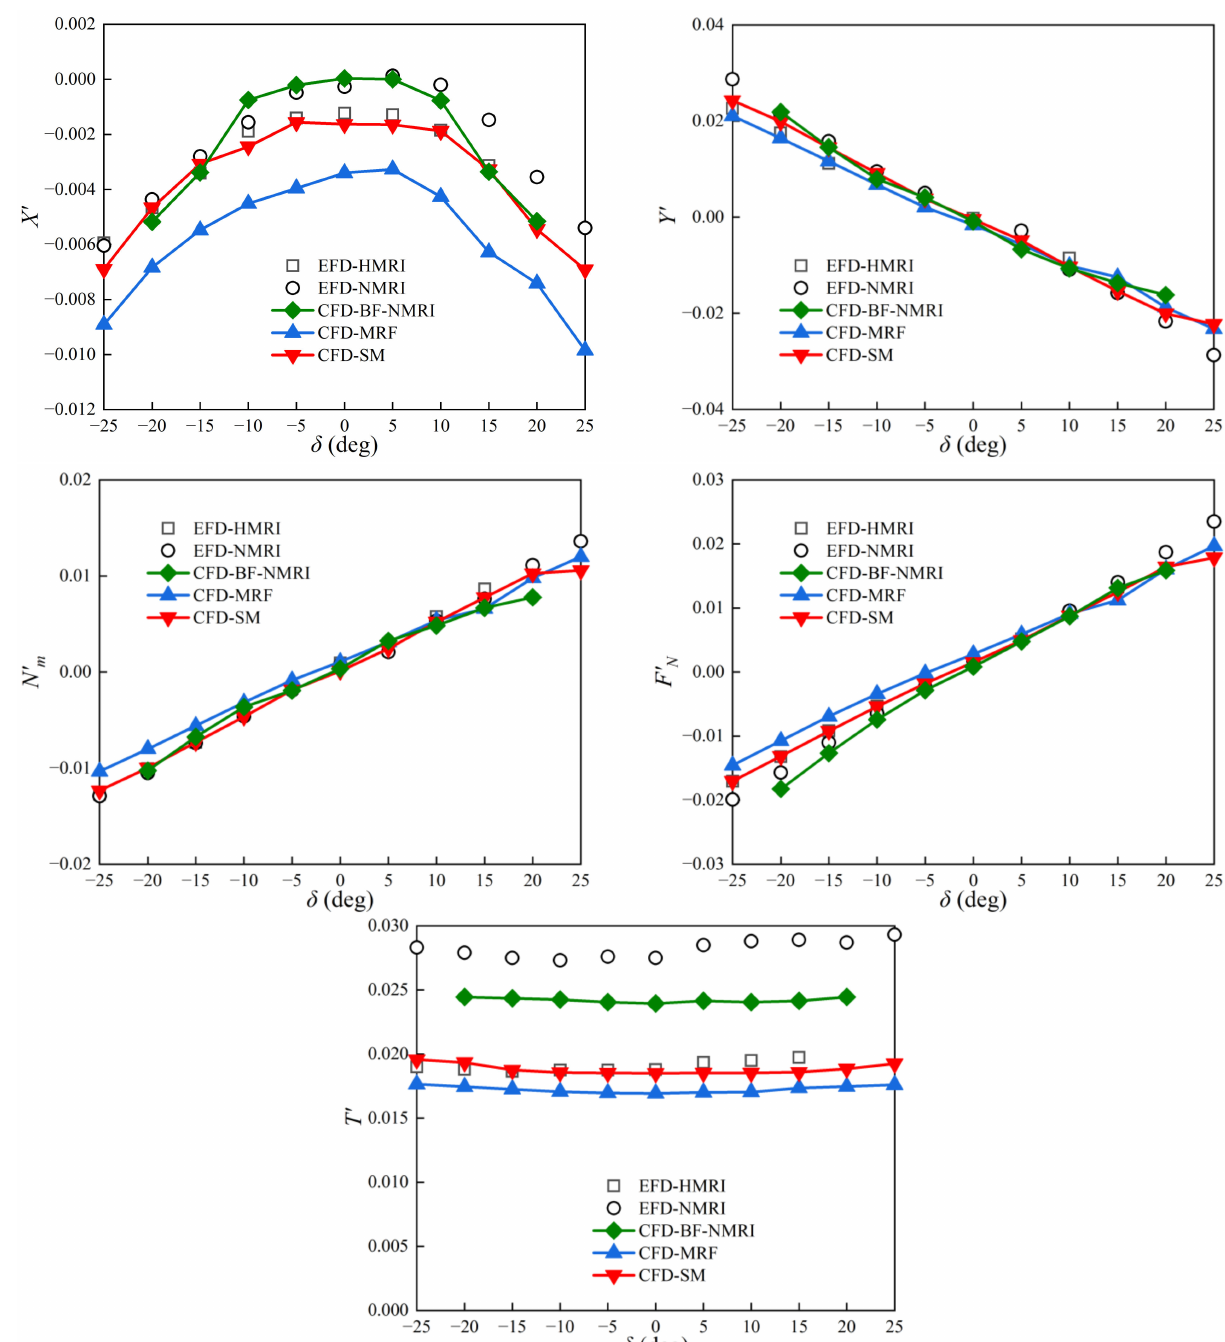
Figure 6. Hydrodynamic quantities in rudder force tests obtained from experiments and